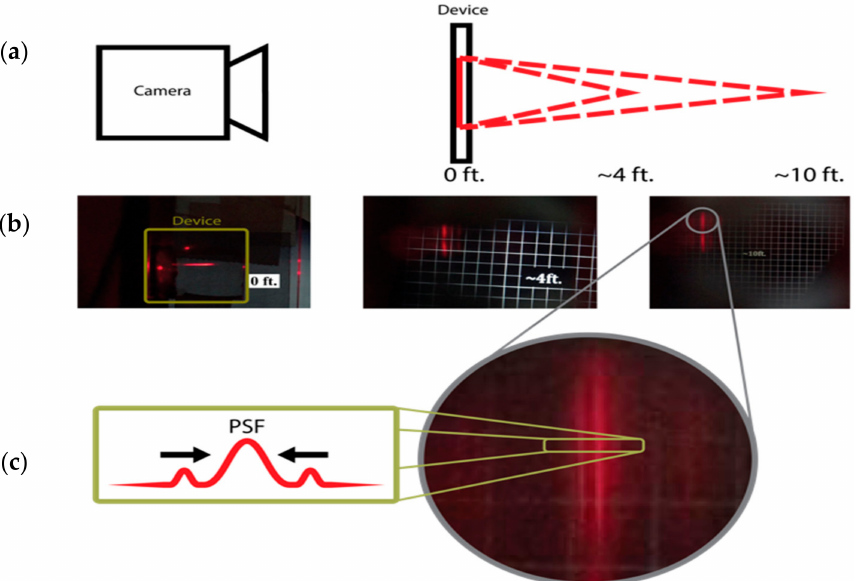
Figure 17. Near-eye guided wave device ( a ) schematic ( b ) aperture at 0, 4, and 10 ft. ( c ) Point spread function of virtual point. Reprinted with permission from